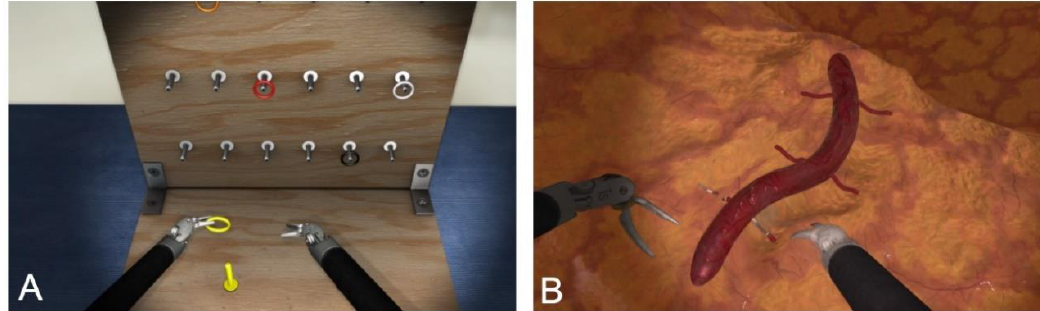
Figure 2. ( A ) Set up for Peg Board and ( B ) for Energy Dissection (pictures from the simulator system of Mimic Flex VR TM obtained with the kind permission of Mimic Simulation).